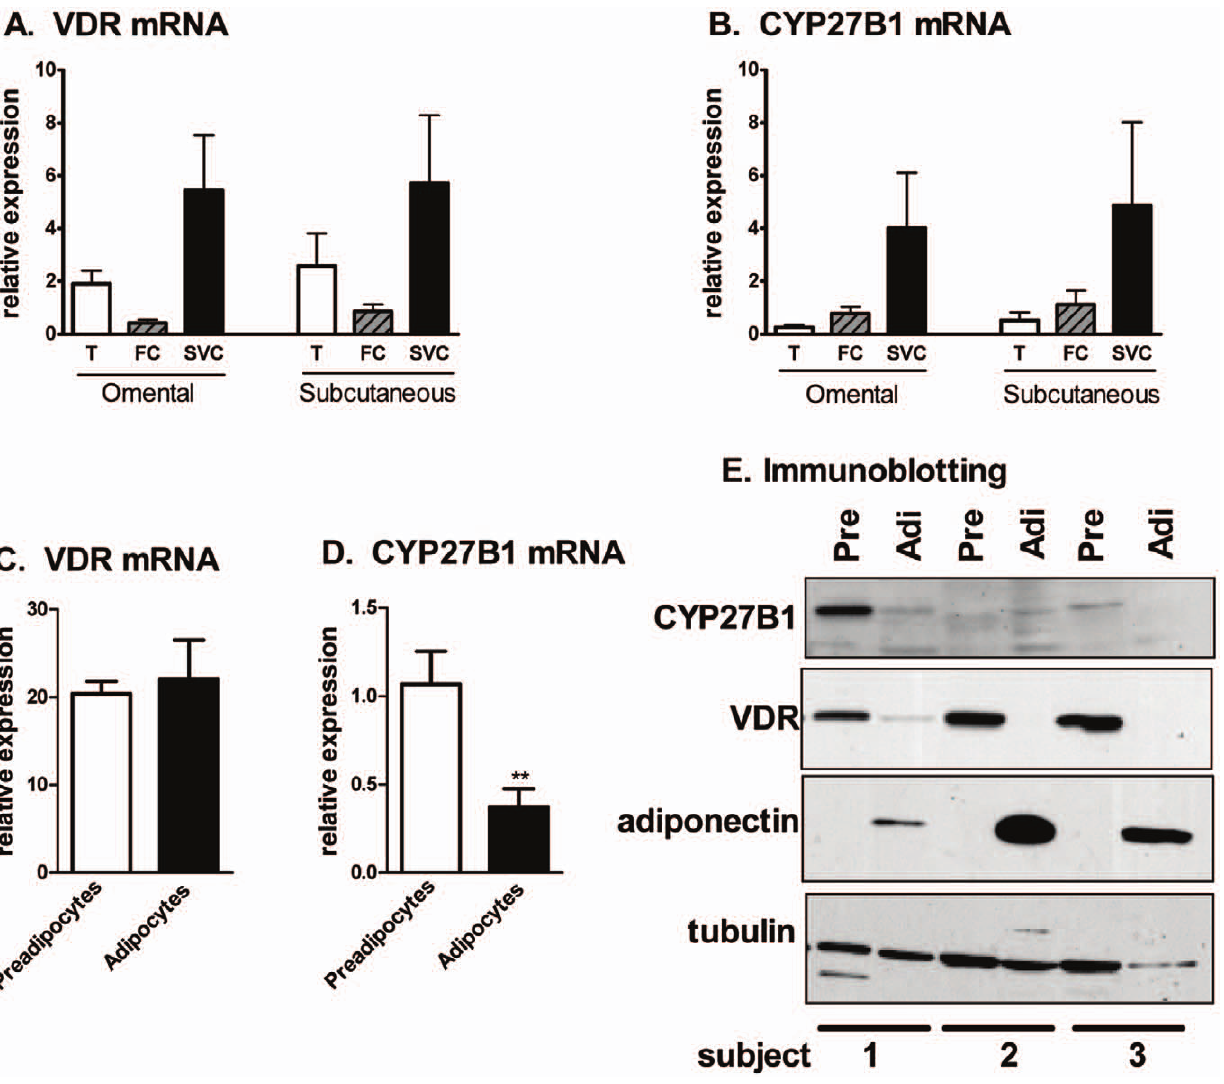
Figure 1. Expression levels of VDR and CYP27B1 in human adipose tissues and primary cultures of human preadipocytes and adipocytes. A and B. Expression levels of VDR and CYP27B1 mRNA were measured in adipose tissue (T), isolated fat cells (FC) and stromal vascular cells (SVC) from human omental and subcutaneous depots (n=4). C and D. Expression levels of VDR and CYP27B1 mRNA were measured in human preadipocytes and newly-differentiated adipocytes (n=5). **, p , 0.01, preadipocytes vs. adipocytes. E. Protein levels of CYP27B1, VDR and adiponectin were measured with immunoblotting in 3 independent subjects before (preadipocytes; Pre) and 14d after differentiation (adipocytes: